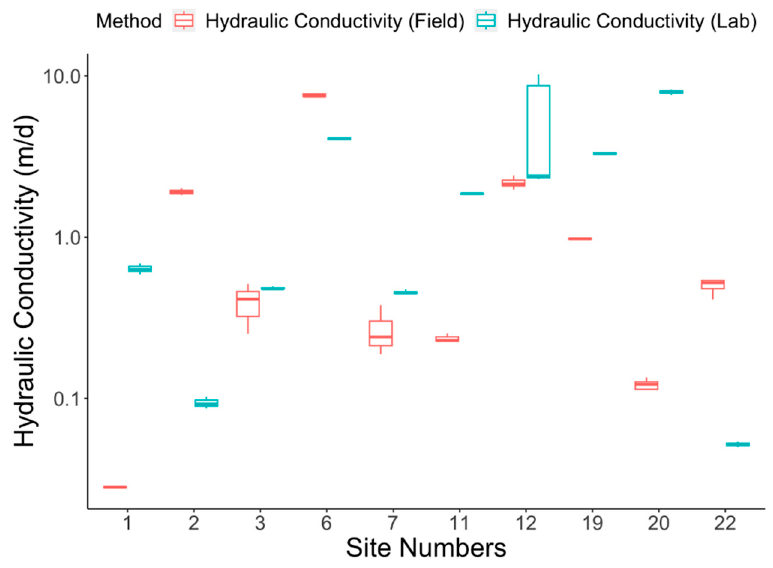
Figure 8. Comparison of laboratory-measured hydraulic conductivity and the field manometer method.